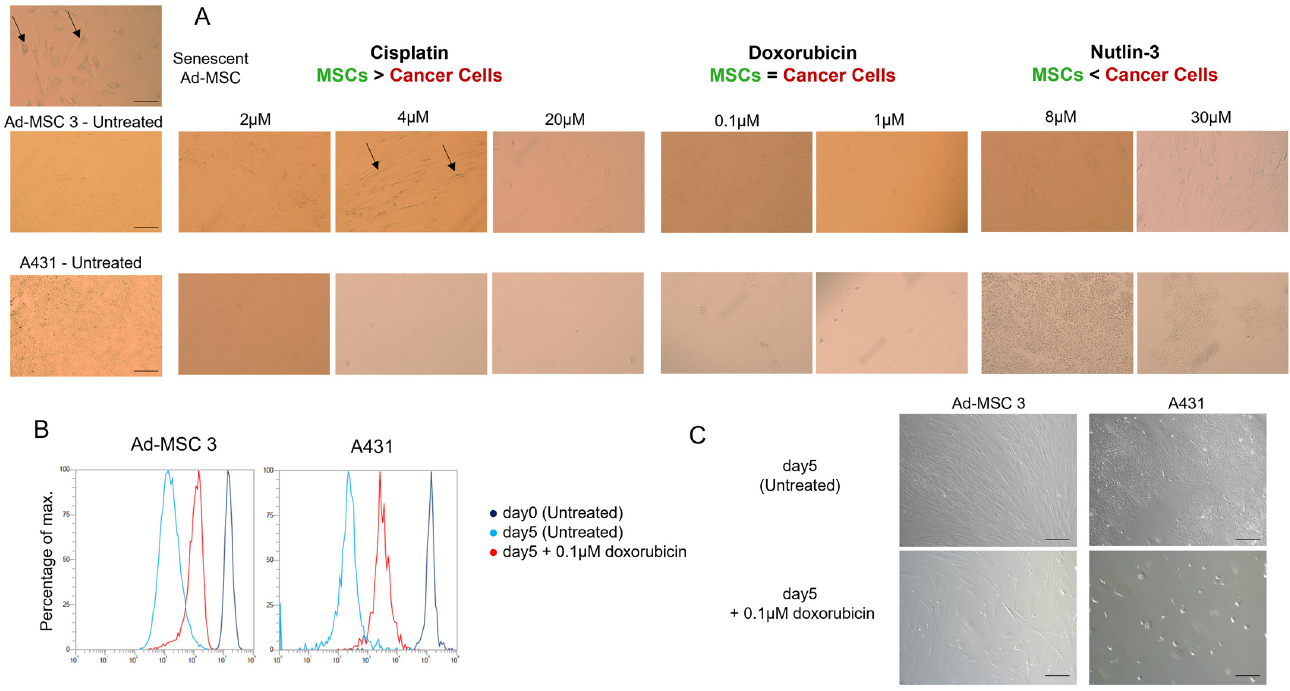
Figure 6. Senescence-associated β -galactosidase (SA- β -gal) staining in A431 and Ad-MSC 3 cells. ( A ) SA- β -gal shows slight positivity to 4 µM cisplatin treatment, and positive control (Senescent Ad- ( A ) SA- β -gal shows slight positivity to 4 µ M cisplatin treatment, and positive control (Senescent MSC 3). ( B ) 0.1 µM doxorubicin five-day treatment decreased the fluorescent signal in CytoTell as- Ad-MSC 3). ( B ) 0.1 µ M doxorubicin five-day treatment decreased the fluorescent signal in CytoTell say in both cell types. ( C ) Cells were imaged under light microscope at 10× objective magnification. assay in both cell types. ( C ) Cells were imaged under light microscope at 10 × objective